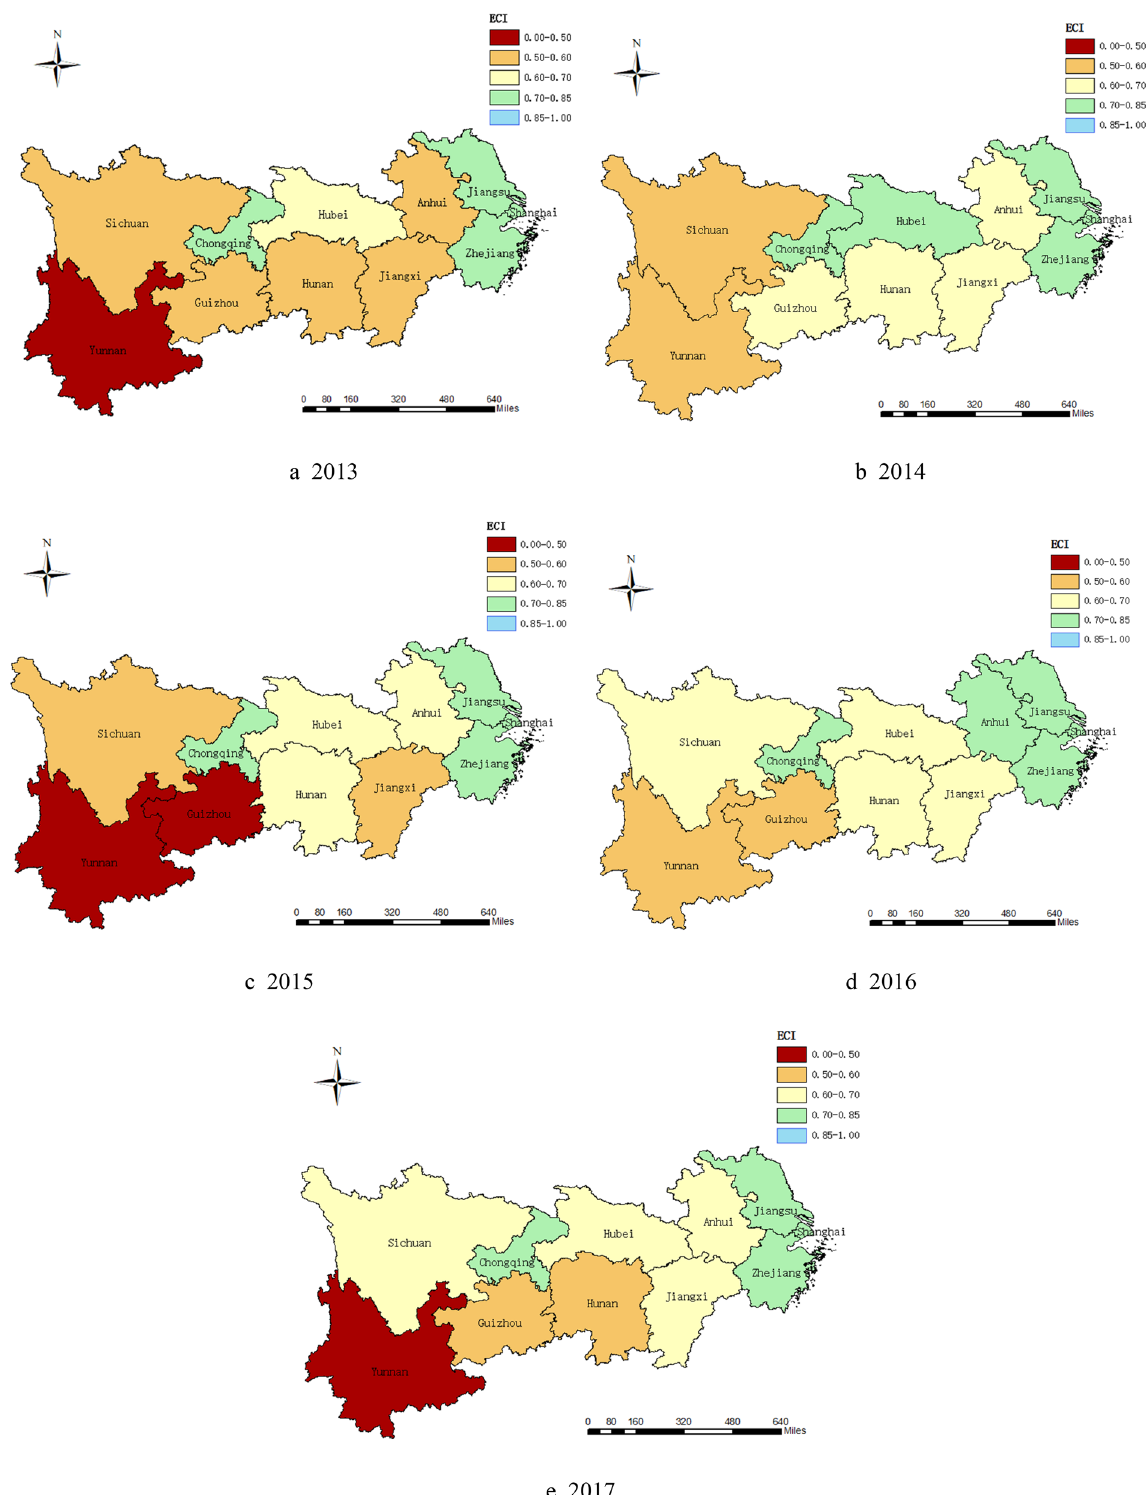
Figure 2. Emergency capacity level of flood disaster in the YREB during 2013–2017. ( a ) Level of regional ECI in 2013, ( b ) level of regional ECI in 2014, ( c ) level of regional ECI in 2015, ( d ) level of regional ECI in 2016, ( e ) level of regional ECI in 2017. The maps were generated by ArcGIS 10.5. https ://www.esri.com/en-us/arcgi s/ produ cts/distr ictin g-for-arcgi s/overv